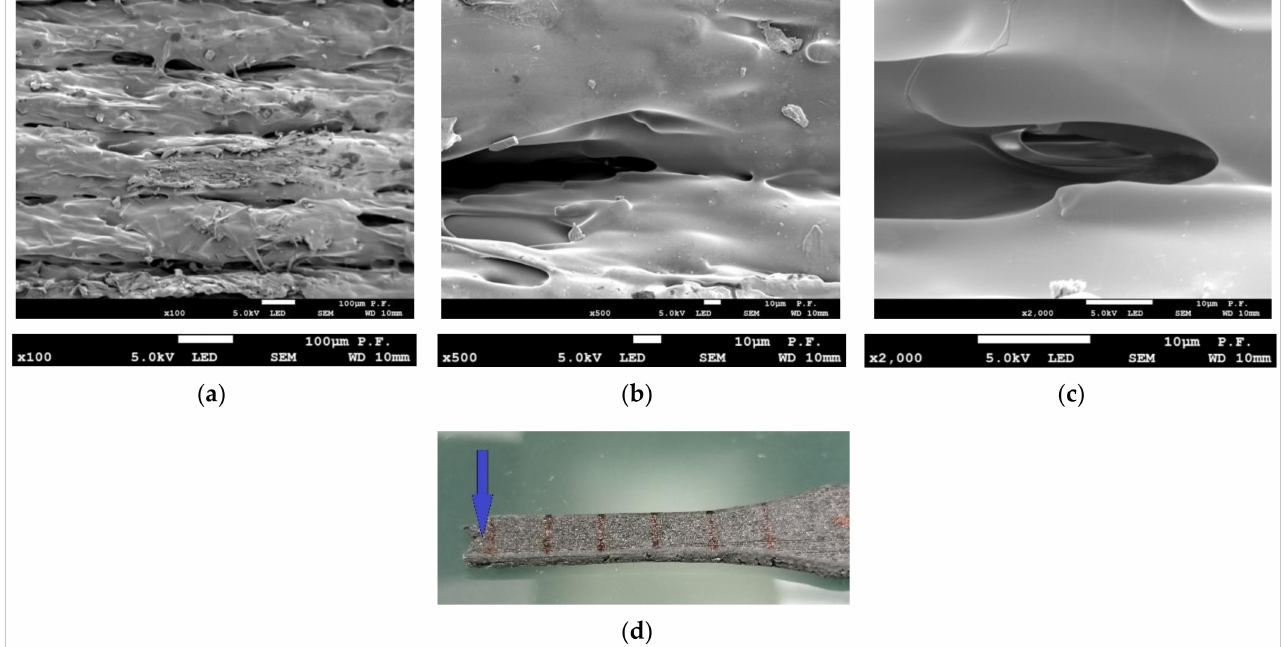
Figure 18. Side views of a 1.8 mm thick PLA-CF specimen after failure, ( a ) × 100 magnification, ( b ) contact zone be- tween two filaments, visible delamination, × 500 magnification, ( c ) delamination at the bonding zone of two filaments, × 2000 magnification, ( d ) view of the tested